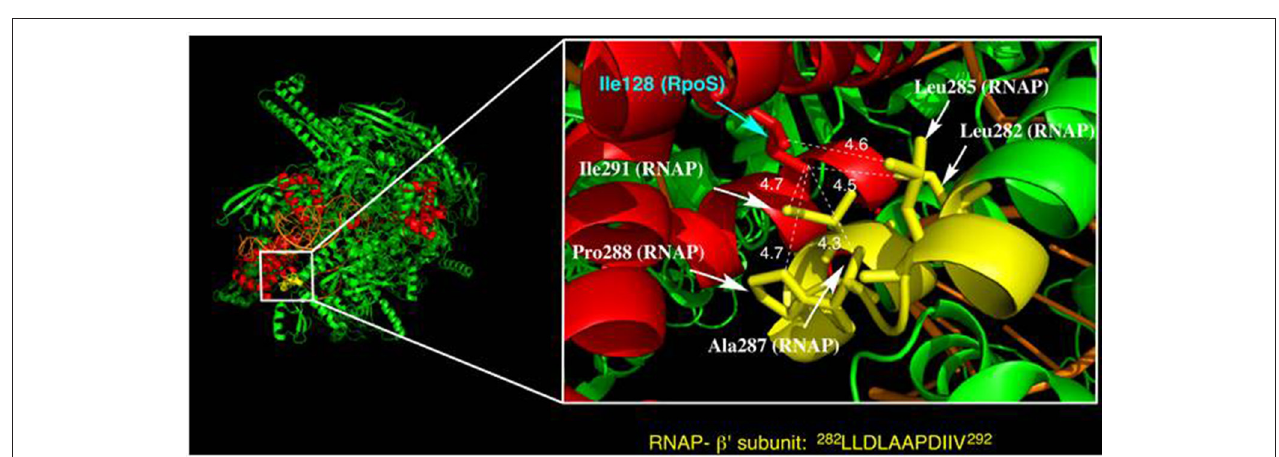
FIGURE 6 | Structure of a ternary complex of RpoS (red), RNAP (green and yellow), and synthetic oligonucleotide (orange) (from PDB: 5IPL). The magnified figure depicts the vicinity of Ile128 in RpoS. Amino acid residues in the RNAP b’-subunit near Ile128 of RpoS are marked in yellow. The moiety marked in yellow is a hydrophobic residue-rich region (see the amino acid sequence). Leu282, Leu285, Ala287, Pro288, and Ile291 in the RNAP b’-subunit face Ile128 of RpoS with distances of < 5 Å.